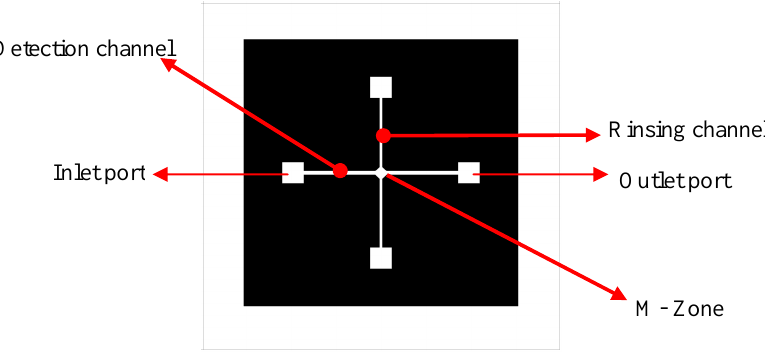
Figure 2 : Schematic of the microfluidic